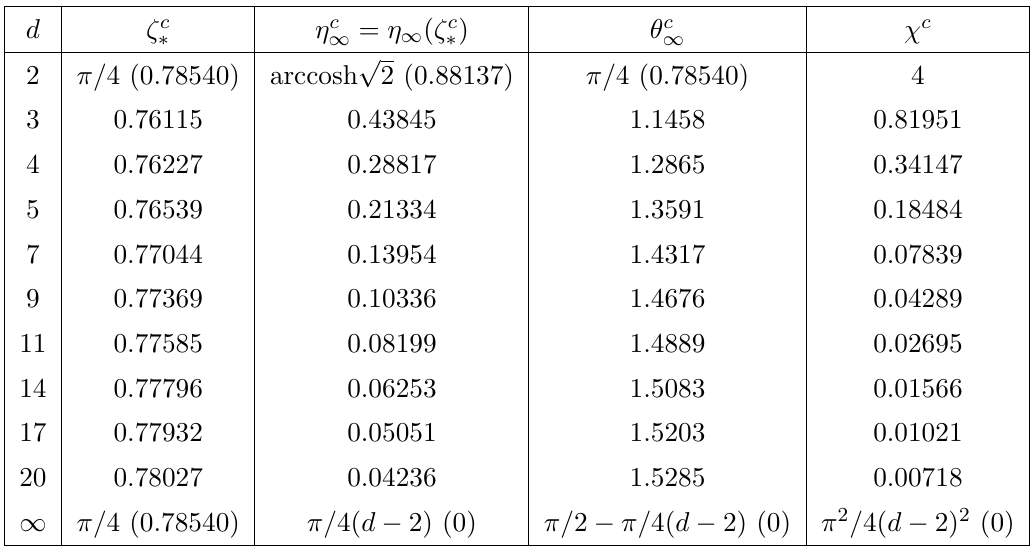
Table 1 . A table containing the numerical values of the critical parameters (cid:16) c various dimension in the range d = 3 through d = 20, with analytic results in d = 2 and d ! 1